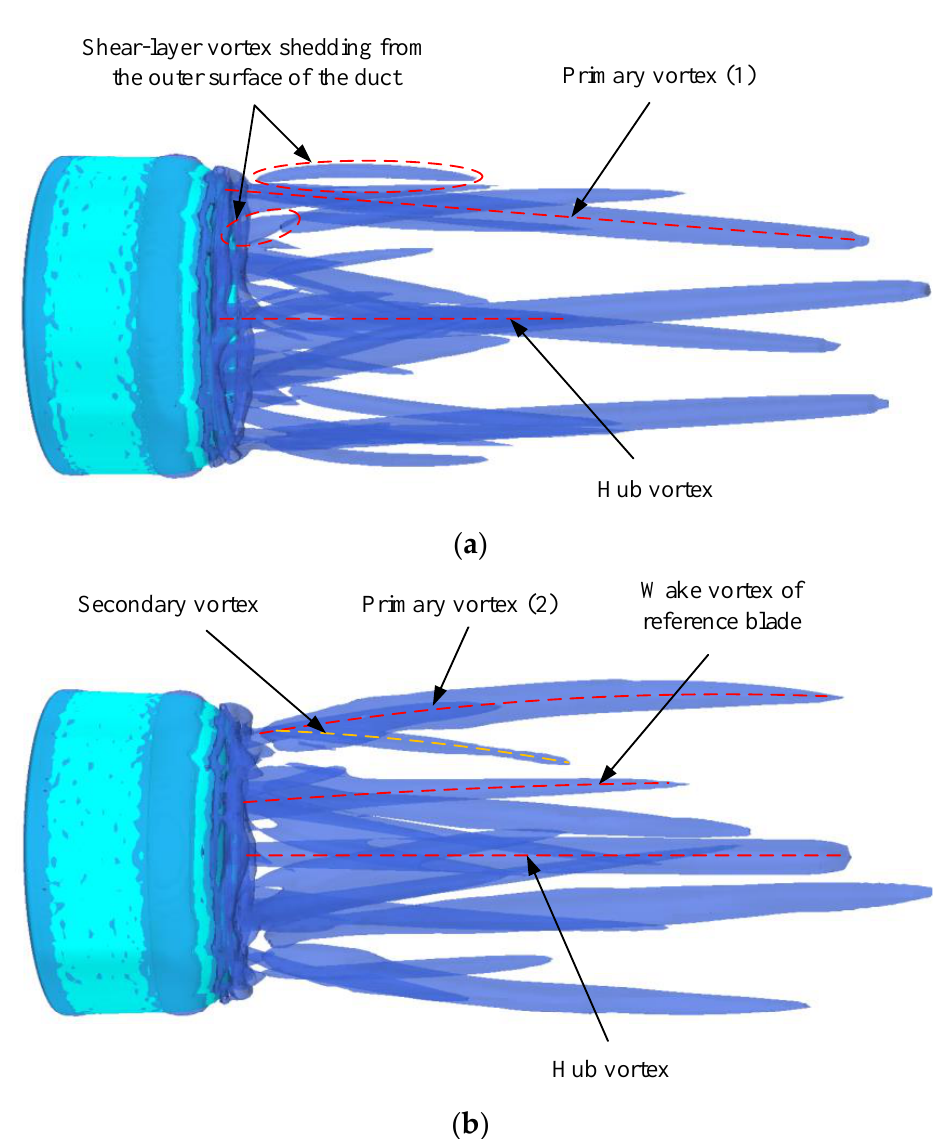
Figure 13. Vortical structures of the RDT wake. ( a ) Prototype RDT. ( b ) Optimized RDT.